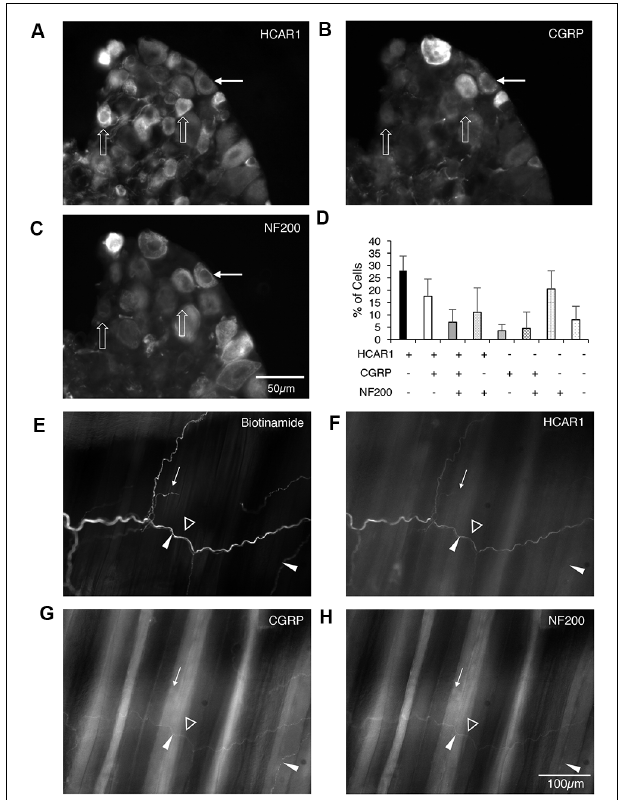
FIGURE 5 | Localization of hydroxyl carboxylic acid receptor 1 (HCAR1), CGRP, and NF200 in dorsal root ganglia (T10-L1) and abdominal muscles. (A–C) Thoracolumbar dorsal root ganglion immunohistochemically labeled for HCAR1, CGRP, and NF200. HCAR1-like immunoreactivity was present in small and medium cell bodies which largely lacked CGRP and NF200 (open arrows). A slightly larger cell had low-intensity immunoreactivity for HCAR1 and was immunoreactive for CGRP and NF200 (white arrows). (D) The proportion of nerve cell bodies with various combinations of the 3 markers is shown (200 cells; n = 4). (E) A bundle of axons and some single axons branching in the connective tissue between abdominal muscle layers were revealed by biotinamide tracing with autofluorescent striated muscle bundles visible in the background. HCAR1 was present in some of the axons in bundles (open arrowhead), and also in a single axon (white arrow). (F) HCAR1-immunoreactive axons ran alongside CGRP immunoreactive axons in bundles ( G ; white arrowheads) but were not located in the same axons. (H) Some axons in biotinamide-labeled bundles were also labeled with NF200 antiserum (open arrowhead).